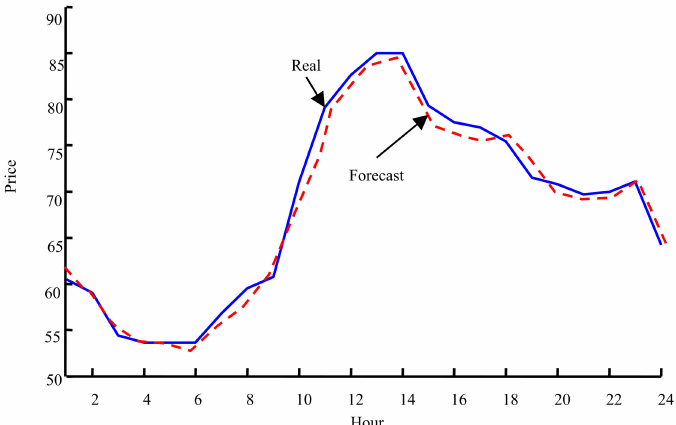
Figure 10. Simulation results for Spain’s system for the 24 h period; continuous blue line (the real value) and the dotted red line (the forecast